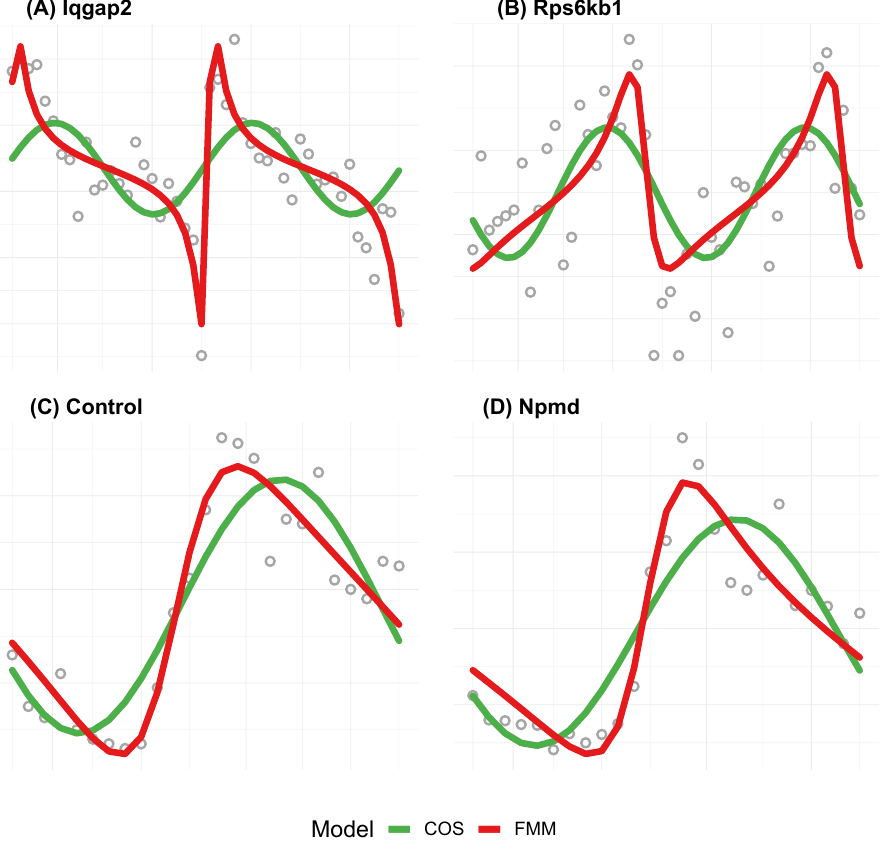
Figure 1. Top : ( A ) Iqgap2 and ( B ) Rps6kb1 circadian gene expressions from mouse liver along two periods of 24 h. Bottom : Mean Corticoptropin levels in ( C ) control and in ( D ) nonpsychotic major depression (Npmd) along 24 h. Observed data (grey open circles) and fitted values from COS model (green line) and FMM model (red